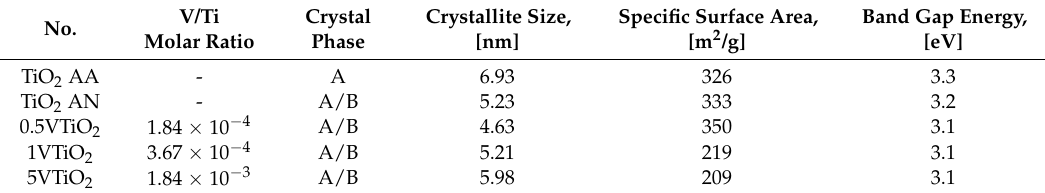
Table 1. Summary of physicochemical properties of TiO 2 and VTiO 2